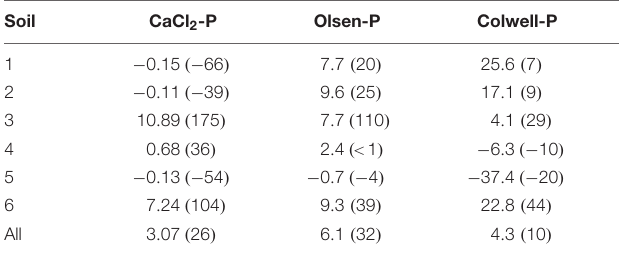
TABLE 3 | Absolute and percentage error (in brackets) model prediction, compared to the observed P final concentrations for each P measure and soil, and across all